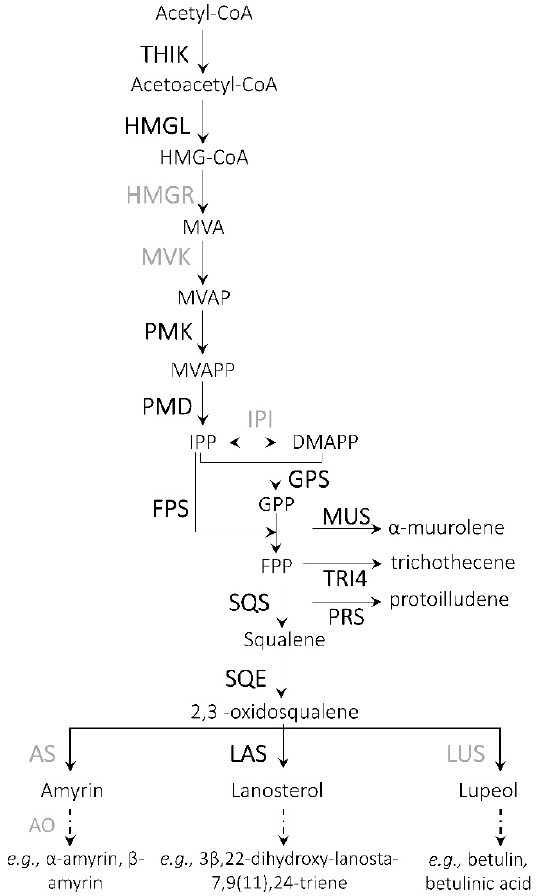
Figure 5. Proposed biosynthetic pathway leading to terpenoids in A. sinapina . Enzymes, for which corresponding gene transcripts were identified in this study, are shown in bold black, whereas the ones not found in our transcriptome are shown in bold grey. A broken arrow represents more than one biochemical reaction. Abbreviations: HMG-CoA—3-hydroxy-3-methylglutaryl-CoA; MVA—